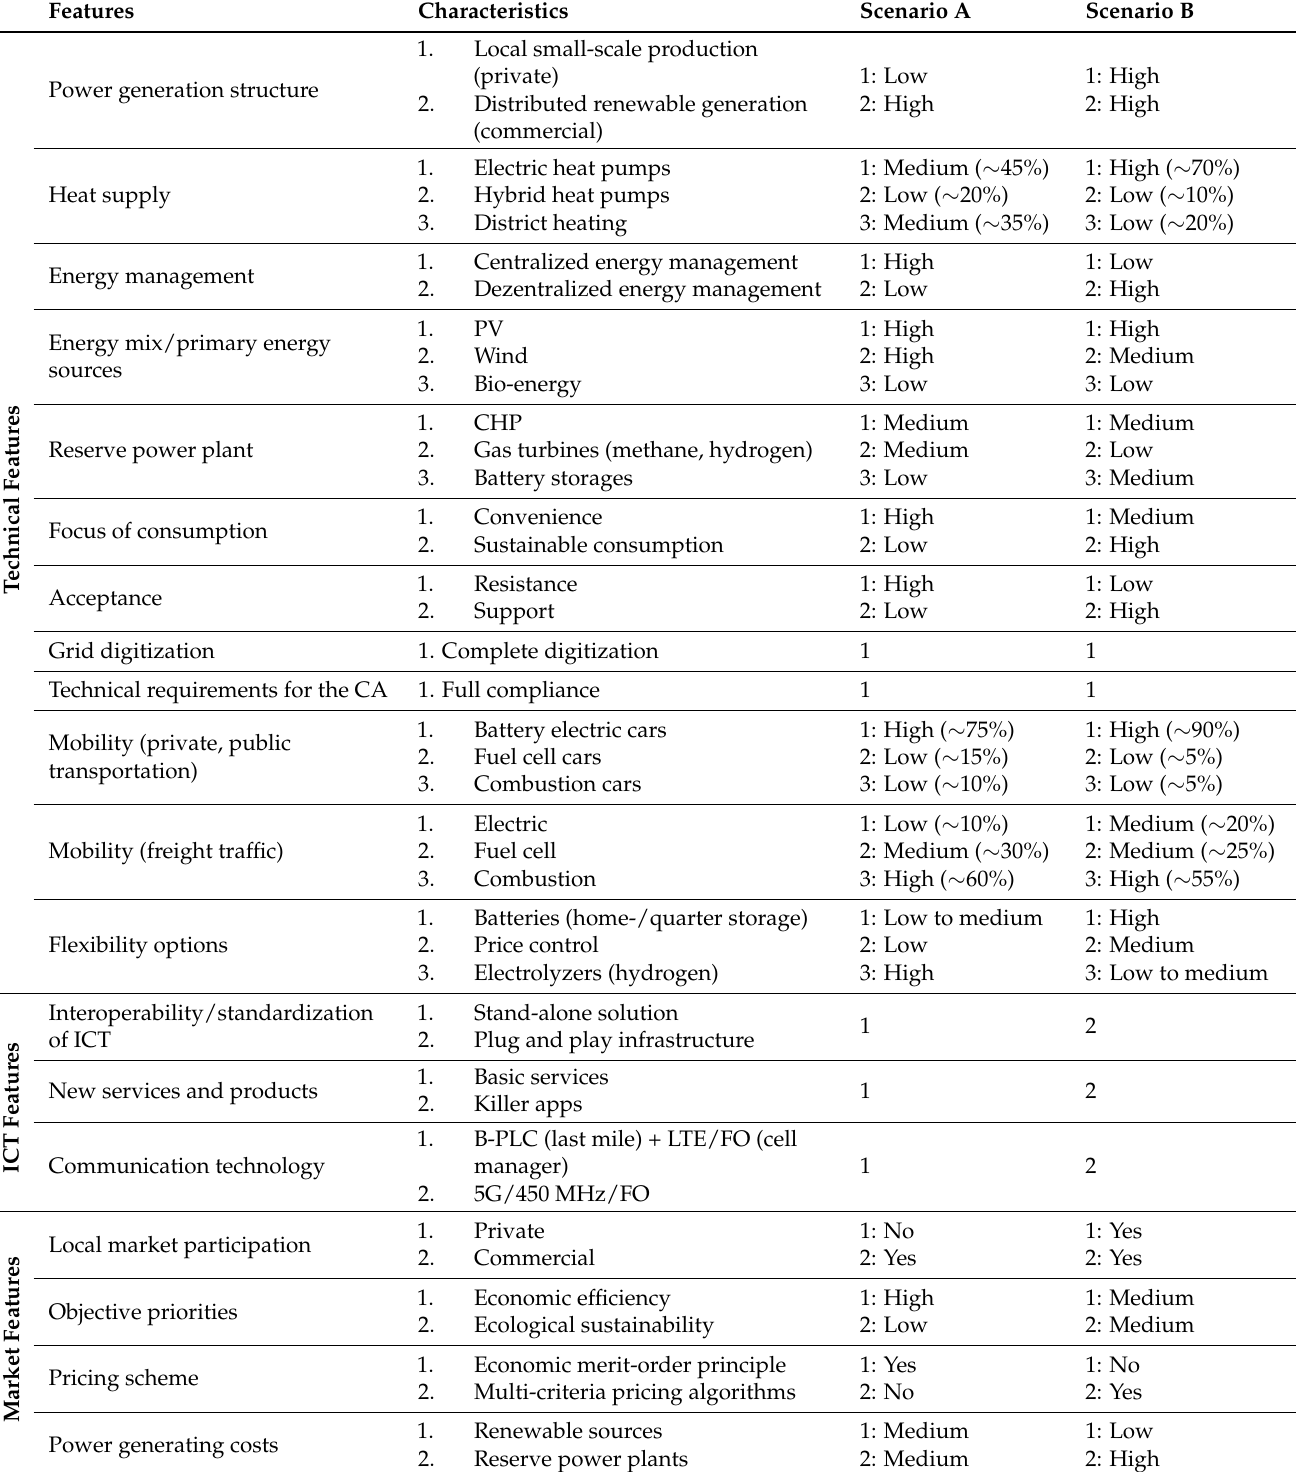
Table 1. Technical, economical and political features for scenario